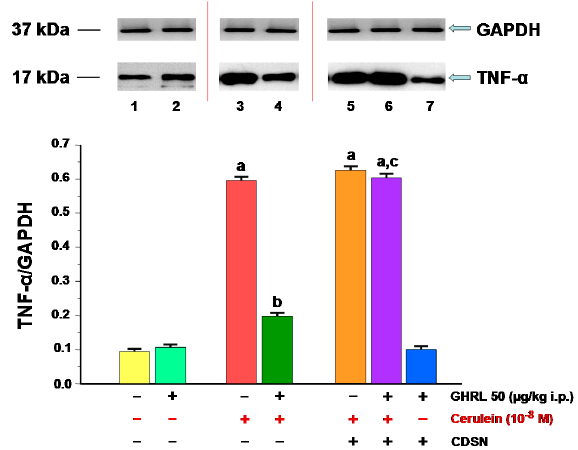
Figure 9. Analysis of tumor necrosis factor- α (TNF- α ) protein synthesis determined by the method of immunoblotting and densitometric analysis of TNF- α /glyceraldehyde-3-phosphate dehydrogenase (GAPDH) protein ratio in isolated pancreatic acinar cells: (lane 1) acinar cells obtained from control sensory nerves (SN)-intact rats treated with saline, after isolation, acinar cells incubated in cerulein-free solution; (lane 2) acinar cells obtained from SN-intact rats treated with ghrelin (GHRL), after isolation, acinar cells incubated in cerulein-free solution; (lane 3) acinar cells obtained from SN-intact rats treated with saline, after isolation, acinar cells incubated in solution containing cerulein at a concentration of 10 − 8 M; (lane 4) acinar cells obtained from SN-intact rats treated with GHRL, after isolation, acinar cells